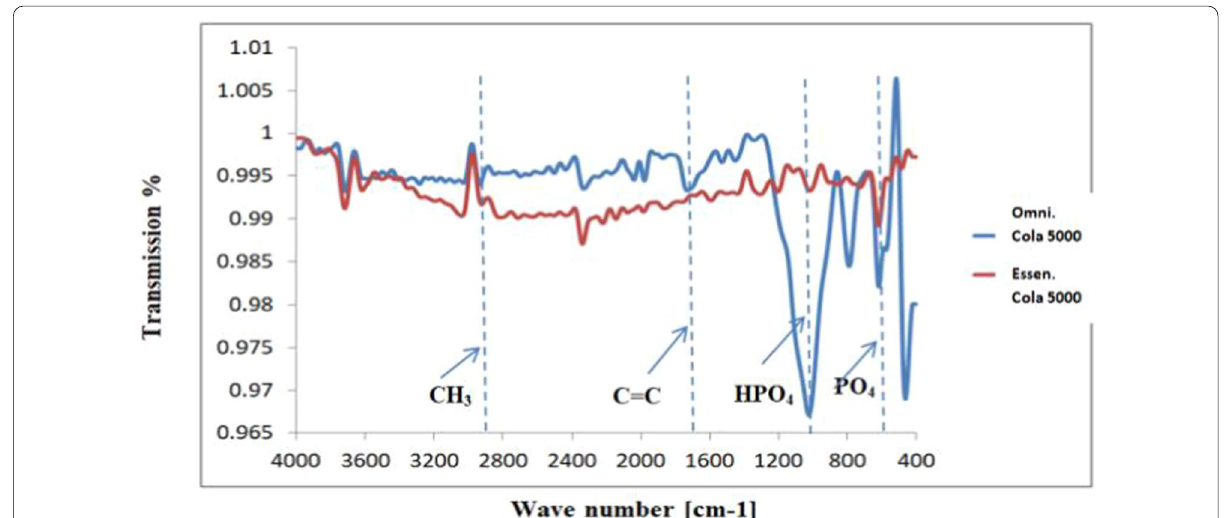
Fig. 11 FTIR spectra representing the chemical structure of Omnichroma Cola 5000 and Essentia Cola